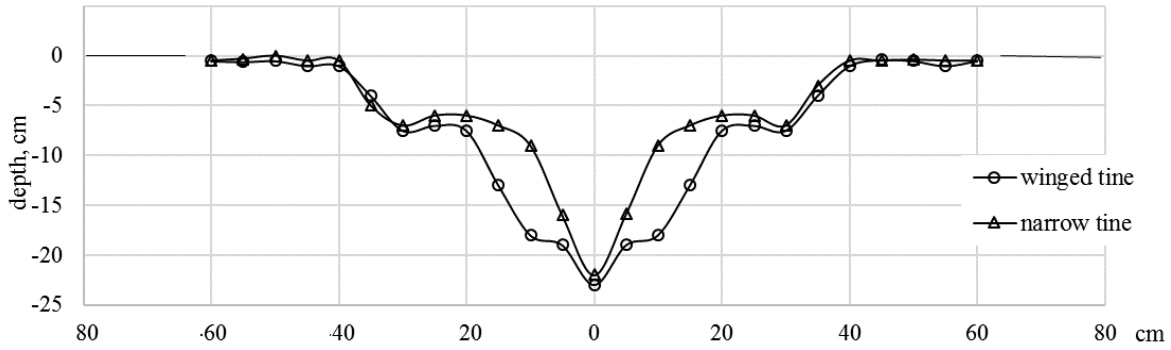
Figure 6. The cross section of bottom of loosed soil in tramlines in dependense ot tine shape.